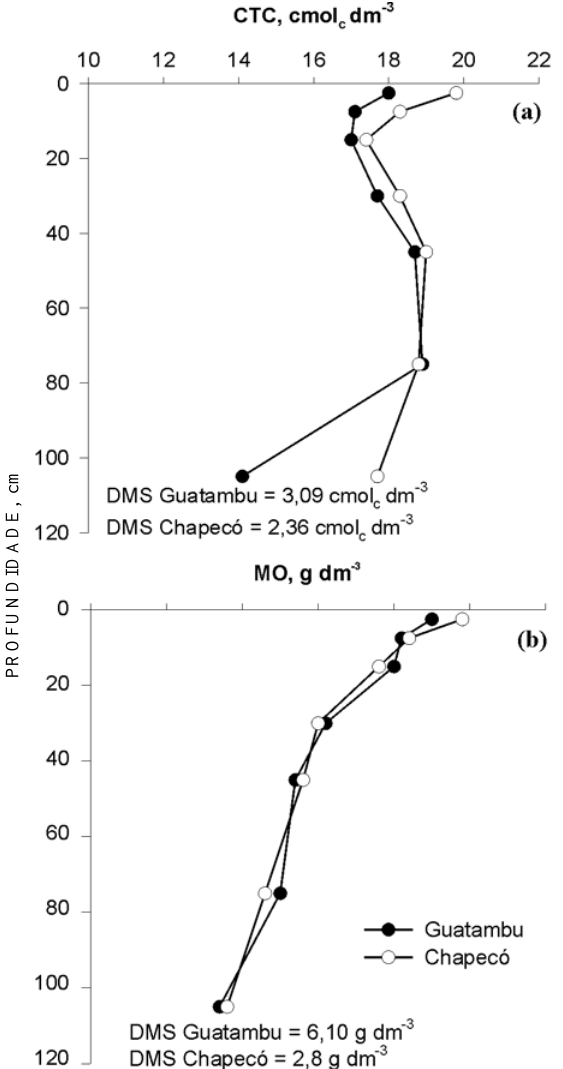
Figura 4. Capacidade de troca de cátions do solo